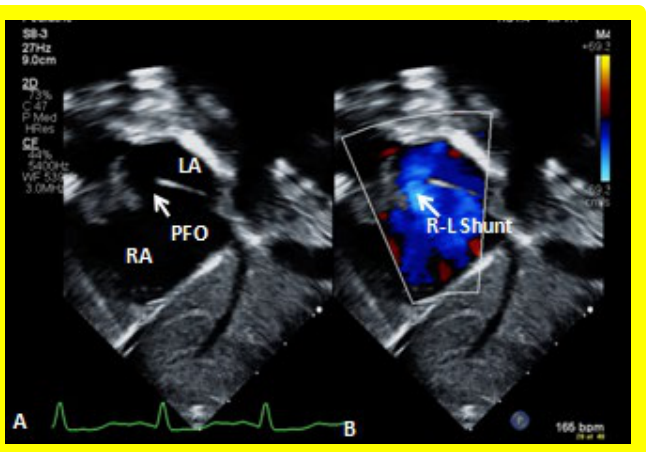
Figure 18. Selected video frames from a subcostal echocardiographic study demonstrating patent foramen ovale (PFO) (arrow in ( A )) with right to left shunt (R-L Shunt) across the PFO (arrow in ( B )). Note laminar flow across the PFO in B. LA, left atrium, RA, right atrium.